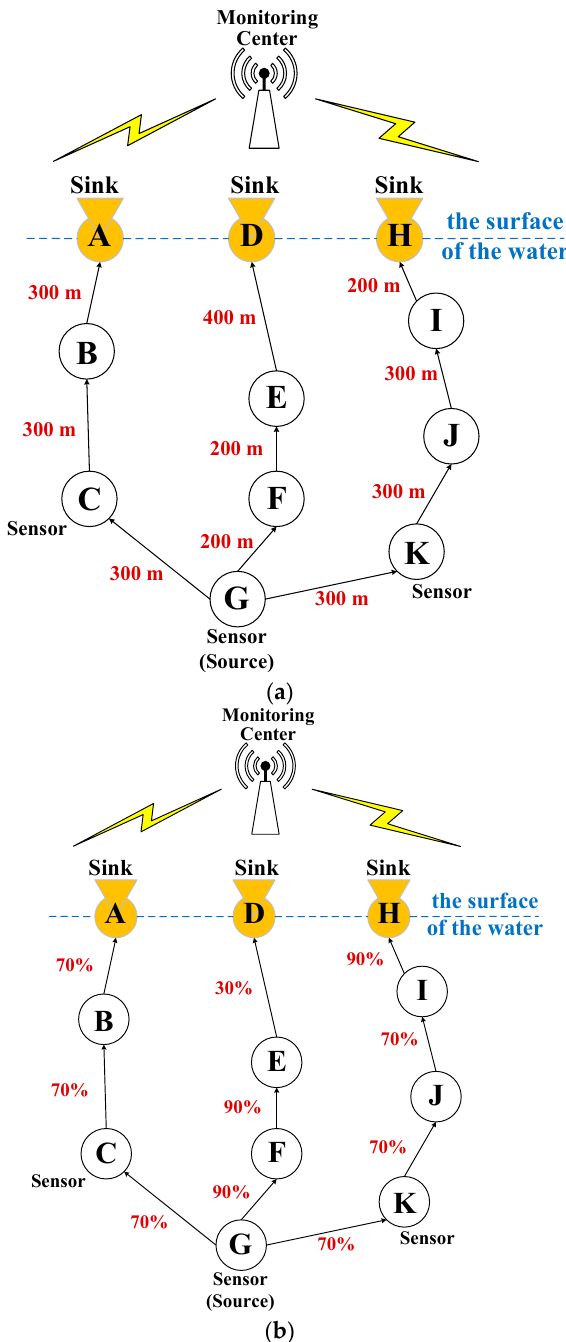
Figure 6. Example of the routing paths in UWSNs with: ( a ) the information of link distance; and ( b ) the information of link reliability.